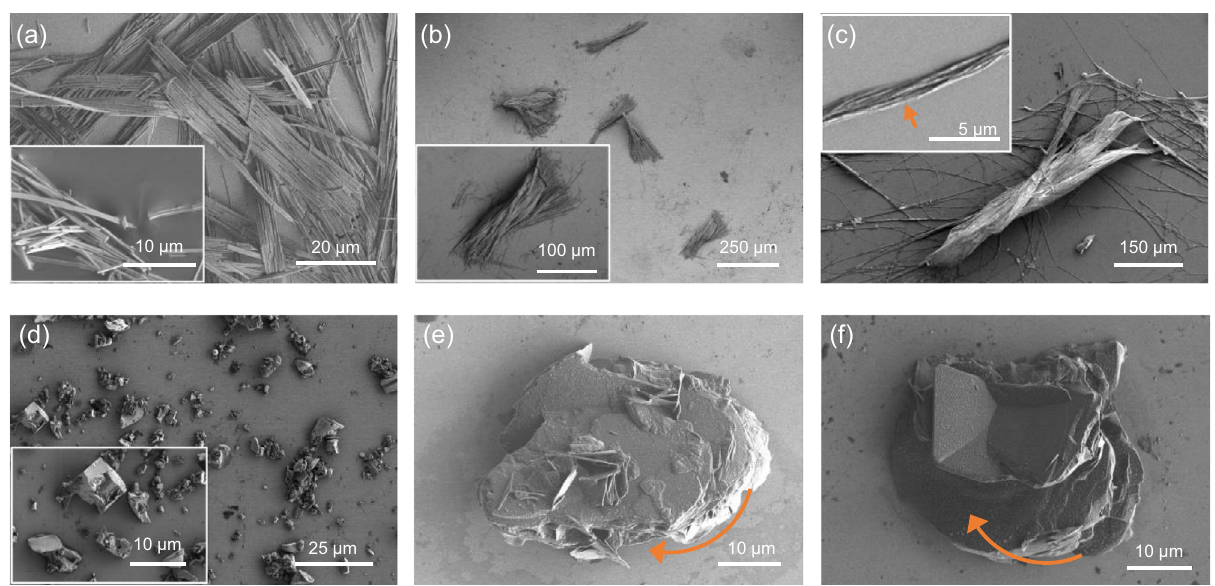
Fig. 6 The typical morphologies of Asp 2 Cu and Asp crystals from their racemic solutions with or without additives. a The typical morphology of rac - Asp 2 Cu when no additive was added (insert picture: enlarged picture of the strands of wirelike crystals). b The typical morphology of D -Asp 2 Cu when 5 L -PMAL was added into the solution of rac -Asp D - wt % 2 Cu (insert picture: enlarged picture of the P-type helical crystal). c A P-type helical crystal of Asp 2 Cu composed of three strands of crystals (insert picture: enlarged picture of one strand of crystals, from which twisted alignment of wirelike crystals in right-handedness can been seen). d The typical morphology of rac -Asp when no additive was added (insert picture: enlarged picture of the granular crystals). e , f The typical morphologies of D -Asp when 1.5 wt % L -PMAL ( L -PMAL: rac -Asp, wt/wt) and 3 e.q. ammonium formate (NH 4 HCO 2 : rac -Asp, mol/ mol) were added into the solution of rac -Asp. The red arrows show M-type helical